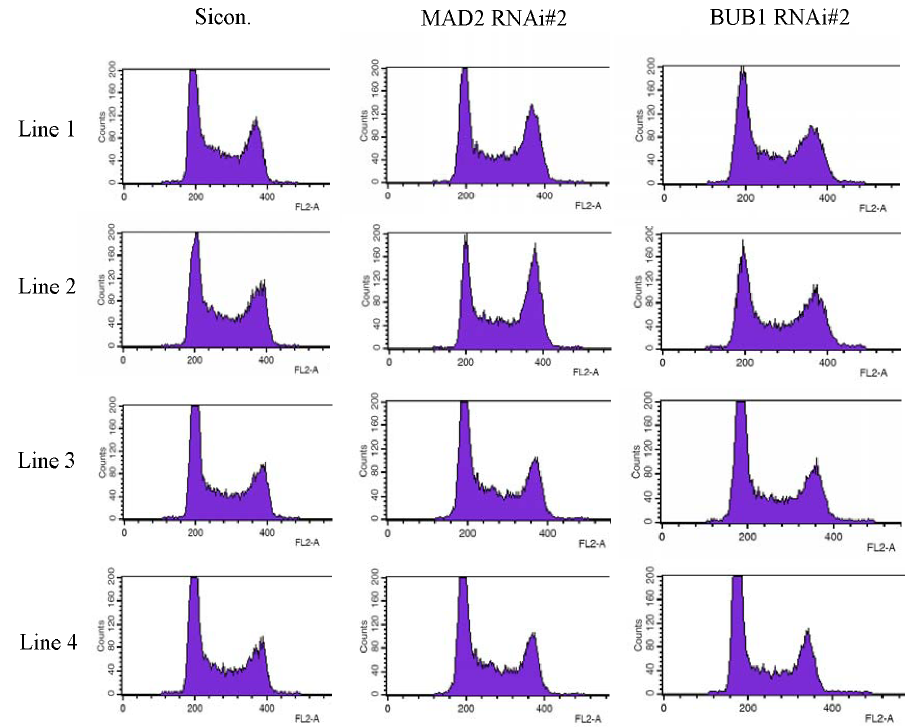
Figure 11. DNA contents in U-2 OS cells knocked down for MAD2 or BUB1 under simulated microgravity. Column 2. U-2 OS cells knocked down for MAD2. Column 3. U-2 OS cells knocked down for BUB1. Line 1. Untreated control (1 g ). Line 2. Simulated microgravity for 24 hours. Line 3. Simulated microgravity for 48 hours. Line 4. Simulated microgravity for 72 hours. G1 peak stays at FL2-A 200 nm in sinco. group under different culture conditions, and is not time-varying. In the cells knocked down for MAD2 or BUB1, G1 peak also locates at FL2-A 200 nm under simulated microgravity for 24 hours, but shifts in the clone of MAD2 RNAi # 2 and BUB1 RNAi # 2.